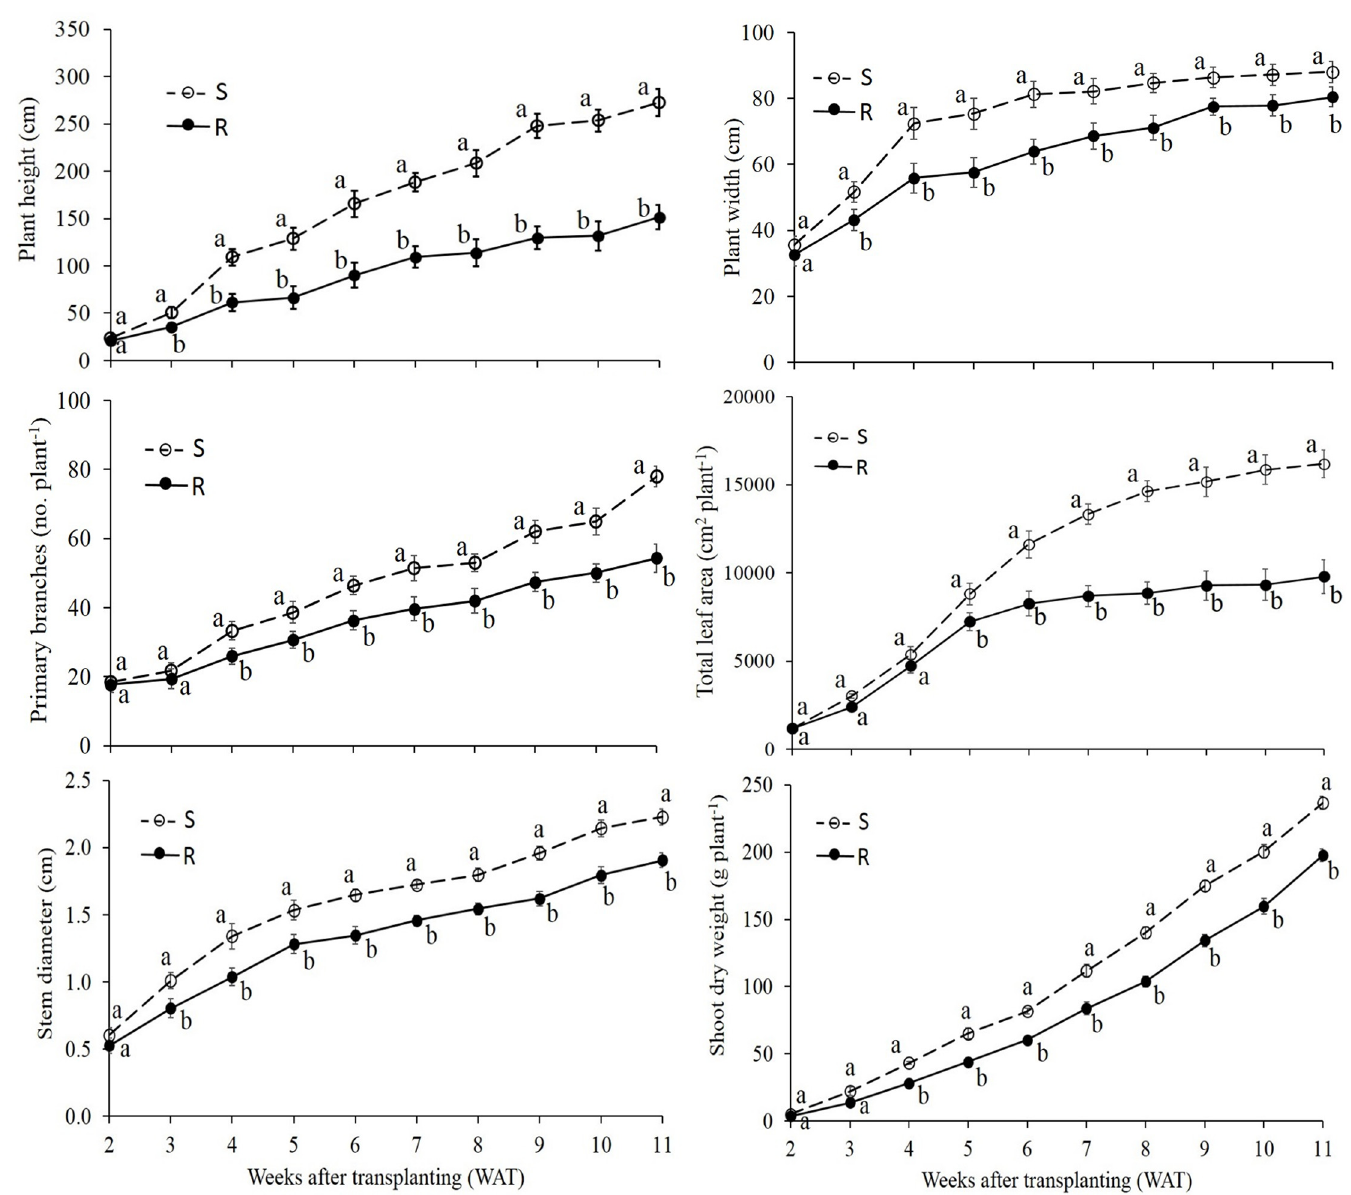
Fig 1. Vegetative growth parameters of dicamba-fluroxypyr – susceptible (S) and – resistant (R) K . scoparia in the noncompetitive growth study averaged over experimental runs. Vertical bar denotes the standard error of the mean. For a growth parameter, similar letters at a harvest date, indicate no difference between the means of R and S selected lines based on the Fisher ’ s protected LSD test at P <